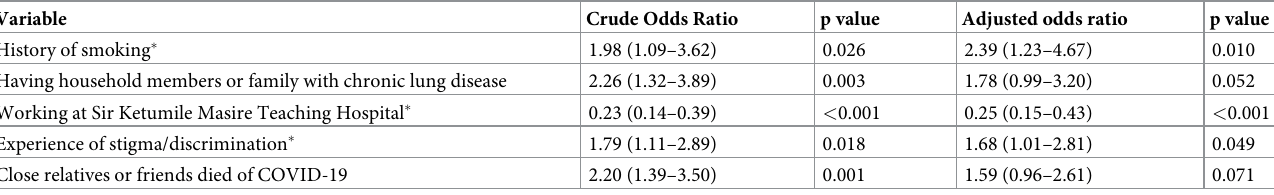
Table 5 shows the predictors of depression in the bivariate and multivariate regression models. The statistically significant predictors of depression in the multivariate model were history of smoking (AOR 2.39, p = 0.010), working at SKMTH (AOR 0.25, p < 0.001) and experience of stigma or discrimination due to line of work (AOR 1.68, p = 0.049). Independent predictors of anxiety were tertiary education (AOR 1.82, p = 0.026), working at SKMTH (AOR 0.49, p = 0.002), having household or family members with chronic lung Table 5. Predictors of Depression among frontline Healthcare workers in Gaborone.